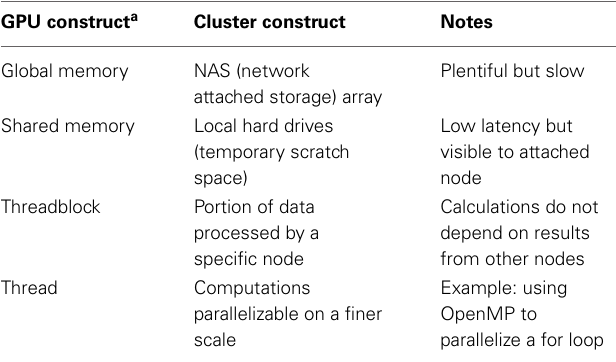
Table 1 | Introduction of GPU constructs using the analogy of a CPU